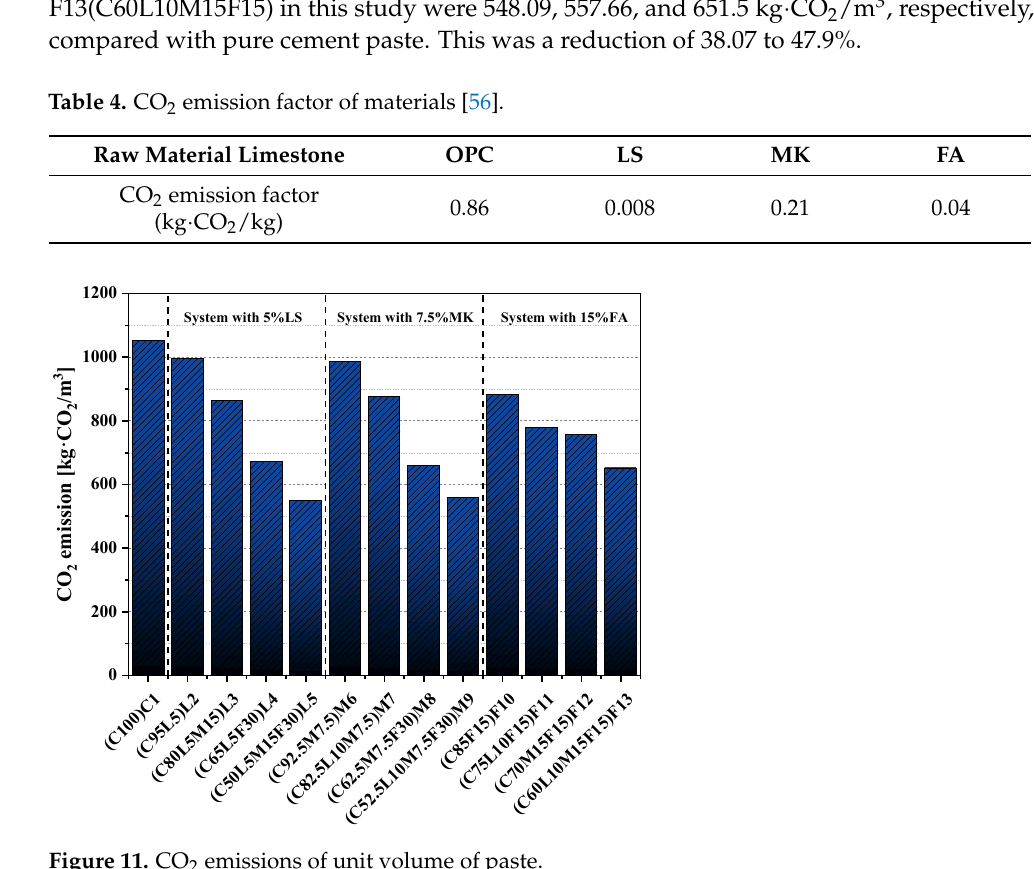
Figure 11. CO 2 emissions of unit volume of